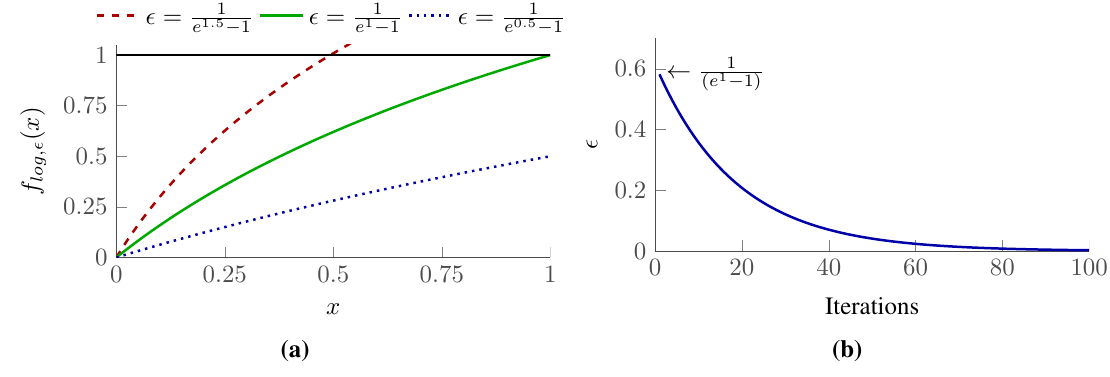
Figure 9. ( a ) Smaller value of (cid:15) defines steeper penalty functions; ( b ) The exponential decay of (cid:15) during the iterative procedure.